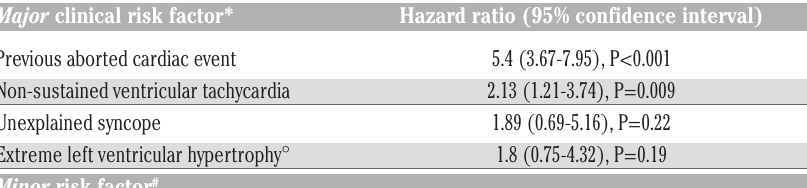
Table 1. Risk factors for sudden cardiac death in childhood hypertrophic cardiomyopa- thy. Major clinical risk